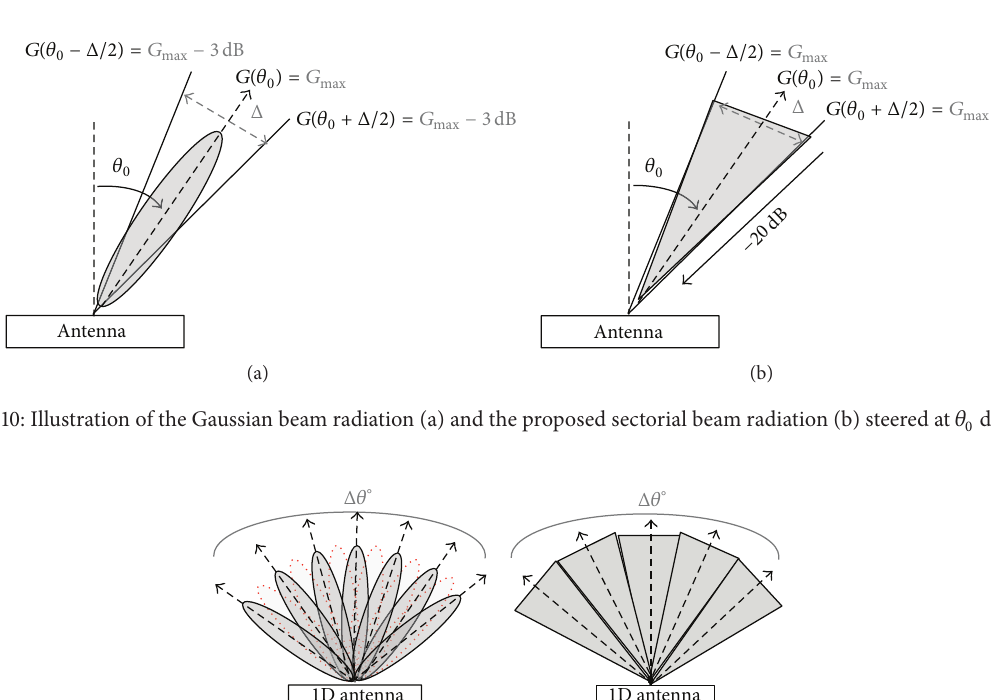
Figure 9: Comparison between simulated and measured normalized Gaussian beams at (a) broadside direction and (b) 30 ∘ pointing angle. = 8.2 GHz. 𝑓 0